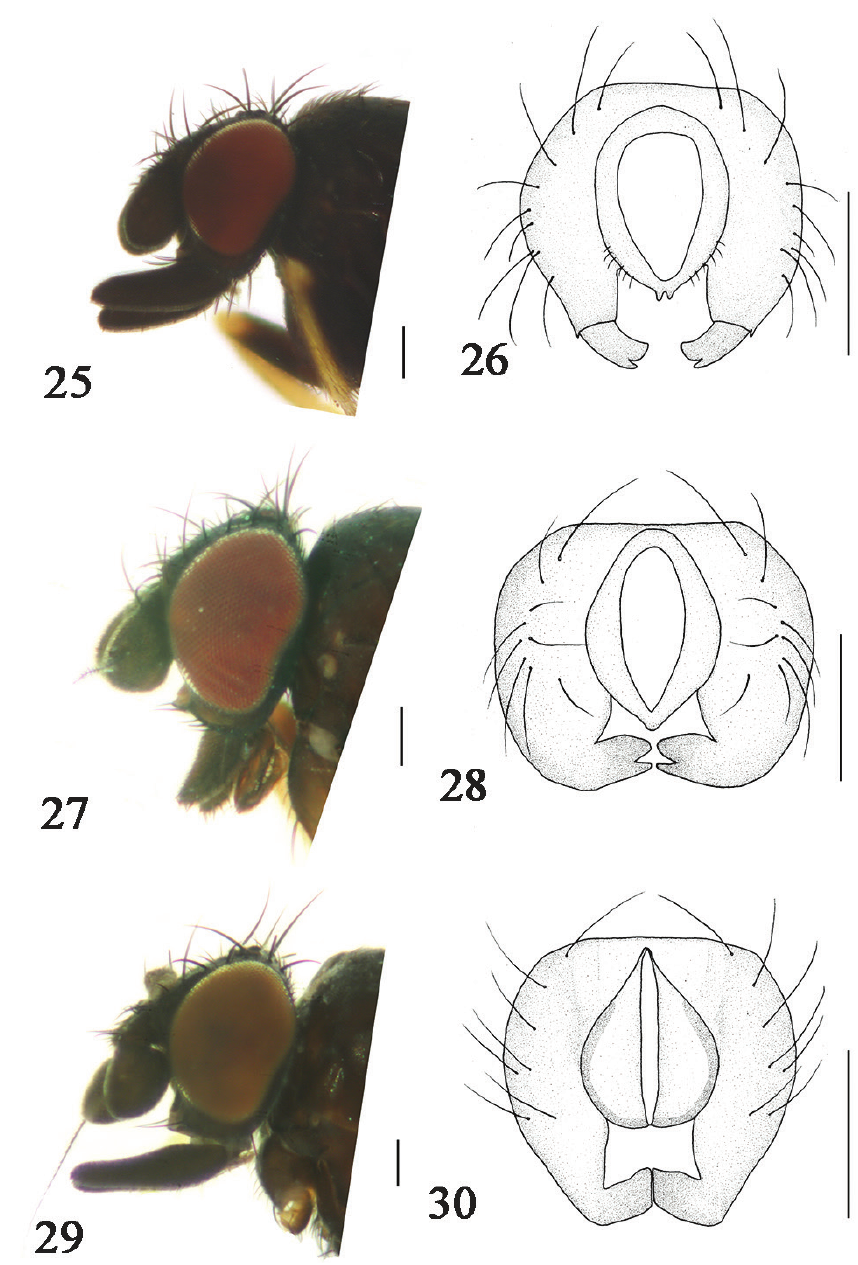
Figures 25–30. 25 Phyllomyza nudipalpis Malloch (male); head, lateral view 26 Phyllomyza nudipal- pis Malloch (male); epandrium, cerci, and surstyli, posterior view 27 Phyllomyza planipalpis Xi et Yang (male); head, lateral view 28 Phyllomyza planipalpis Xi et Yang (male); epandrium, cerci, and surstyli, posterior view 29 Phyllomyza tibetensis Xi et Yang (male); head, lateral view 30 Phyllomyza tibetensis Xi et Yang (male); epandrium, cerci, and surstyli, posterior view. Scale bars: 0.1